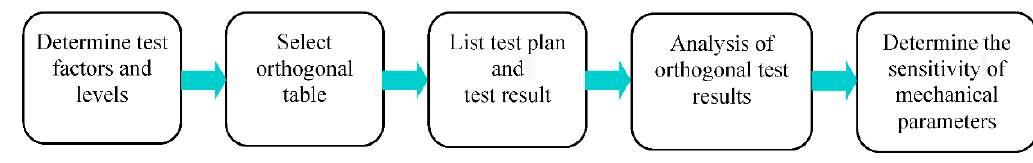
Figure 11. Orthogonal experimental design flow.